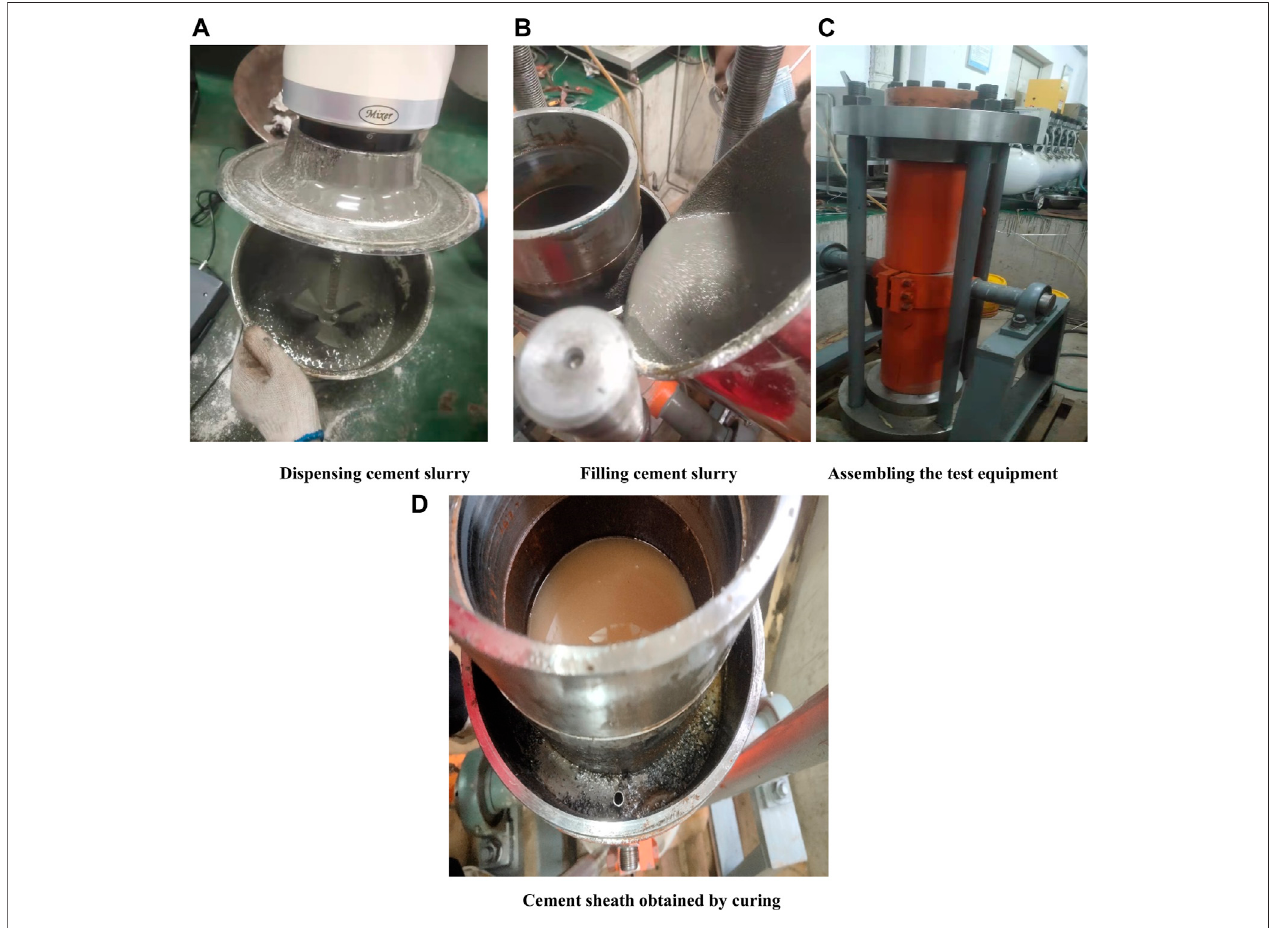
FIGURE 4 | Experimental process.